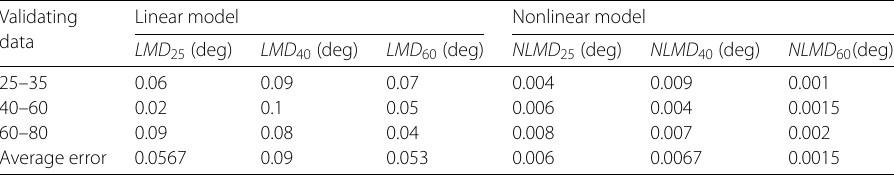
Table 4 Error comparison of the linear and nonlinear models with delay for the yaw responses Validating Linear data